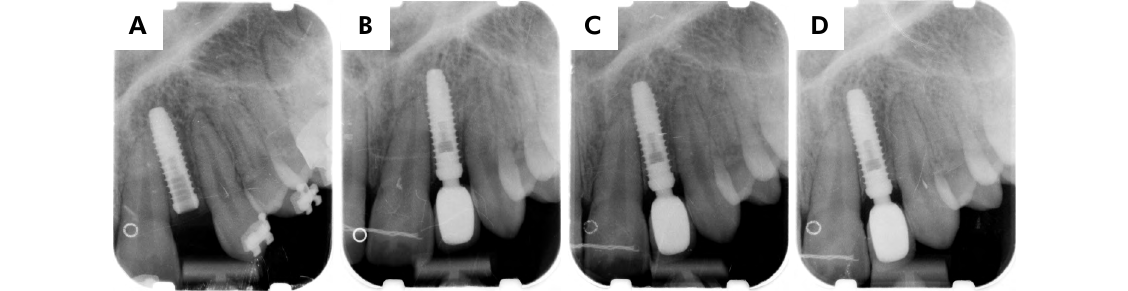
Figure 1. Group 2: (A) radiographic control after implant placement, (B) radiographic control at the fixed permanent prosthesis delivery, (C) radiographic control at 12 months after implant placement, and (D) radiographic control at 24-month after implant